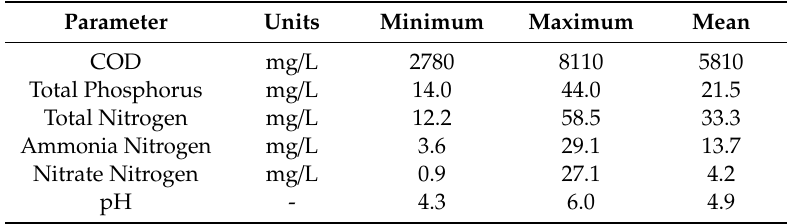
Table 2. Influent wastewater